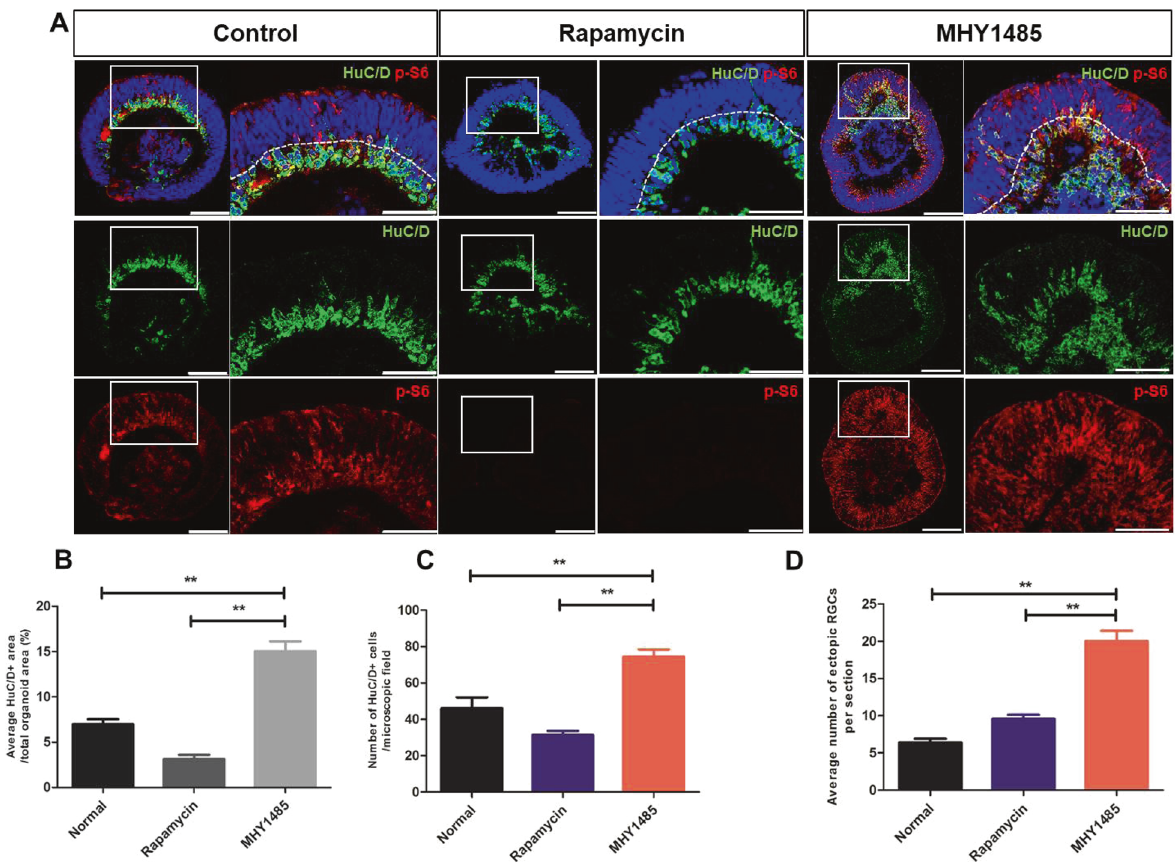
Fig. 5 RGC development and retinal lamination within ROs at 40 days of differentiation after rapamycin or MHY1485 treatment. A RGC development in control, rapamycin-treated, and MHY1485-treated ROs shown by immunostaining of HuC/D (green) and p-S6 (red) at 40 days of differentiation. B – D Quanti fi cation of the ratio of average HuC/D + area, number of HuC/D positive cells, and number of ectopic RGCs in control, rapamycin-treated, and MHY1485-treated ROs. Data are expressed by mean ± S.E.M. ** p < 0.01, by the Kruskal – Wallis test with